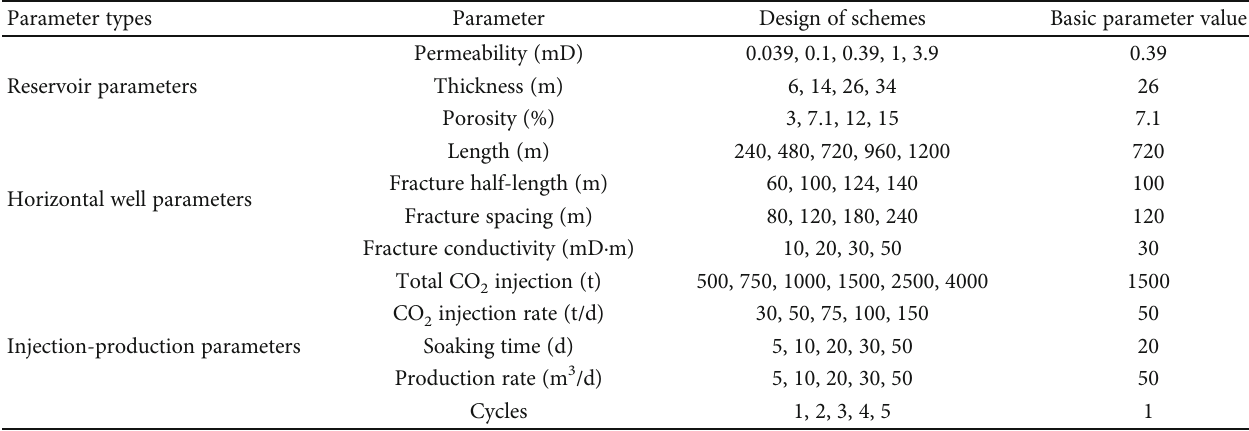
Table 5: Twelve parameters used in the simulation cases.